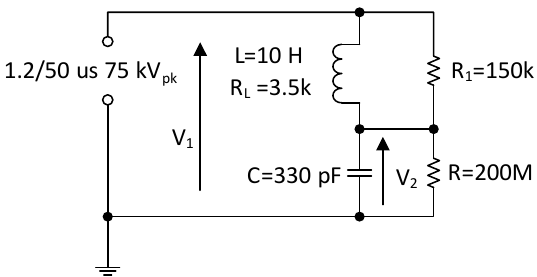
Figure 3. Equivalent circuit diagram of the piezoelectric stack (C and R) and lightning impulse attenuator, L, R L and R 1 .